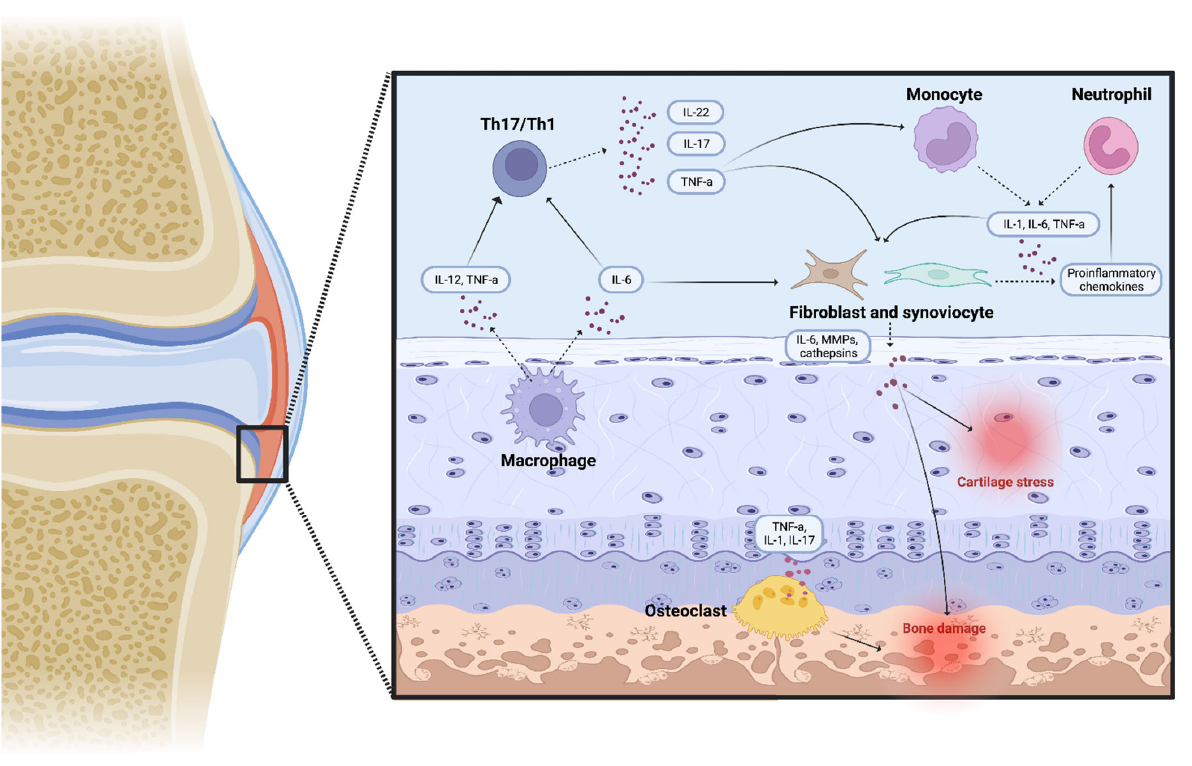
Figure 2. Several proinflammatory molecules and immune cells combine to form an inflamed environment in oJIA and pJIA, which leads to osteoclast activation, cartilage stress, and bone damage (created with “BioRender.com”, accessed on 16 January 2023).